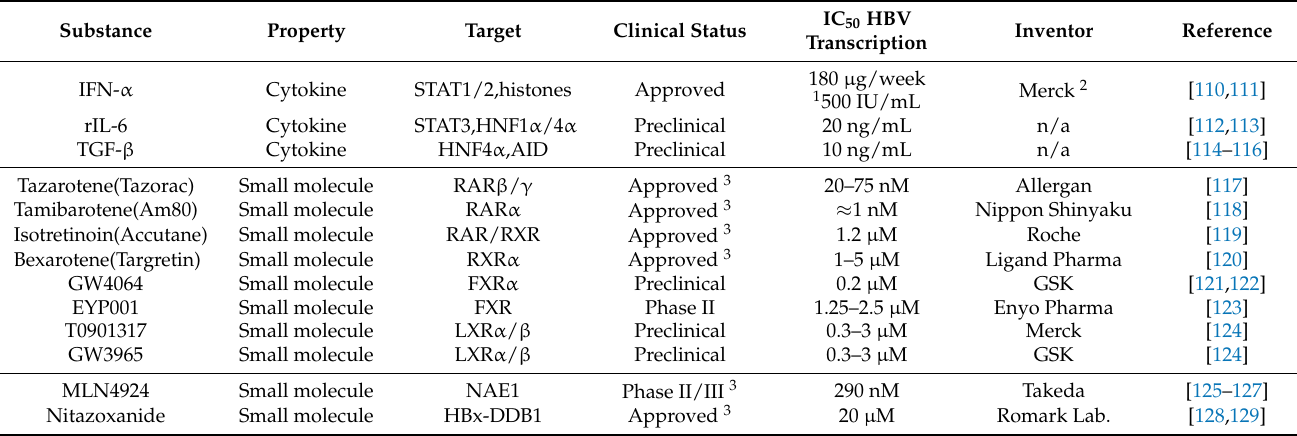
Table 1. Inhibitors targeting HBV